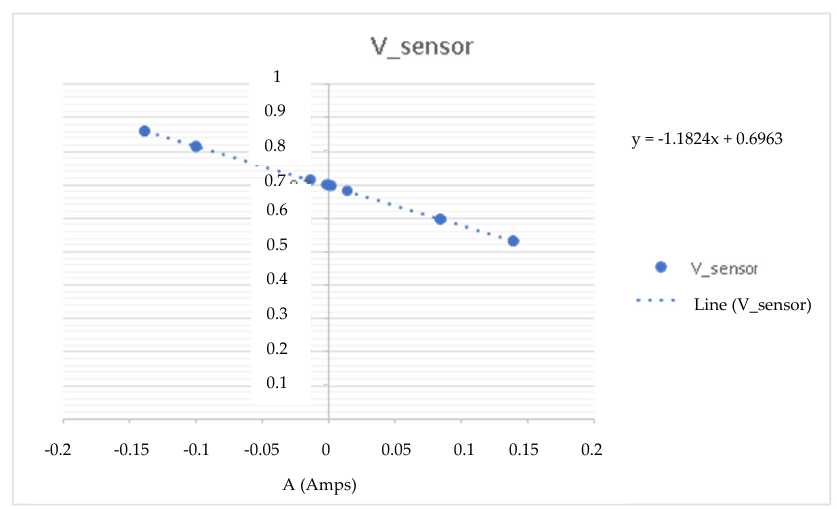
Figure 8. Voltage at the sensor.